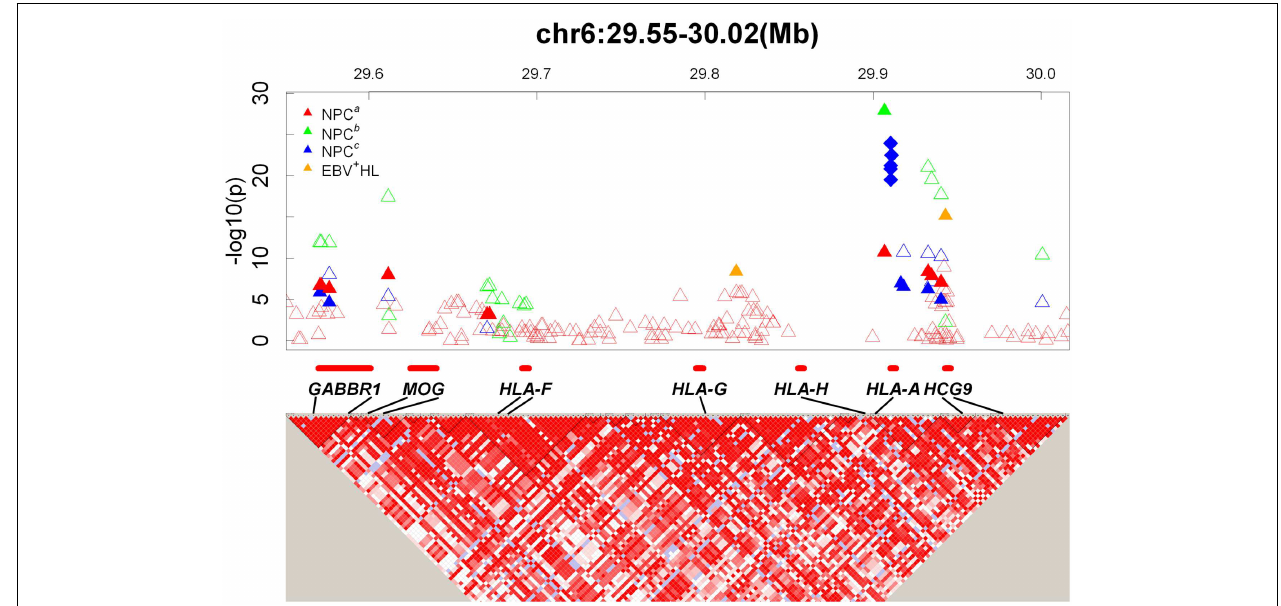
significant SNPs reported in GWASs.The hollow triangles indicate other SNPs listed in the supplementary documents.The solid diamonds indicate significant amino acids located within the HLA genes (12). Bottom: Detailed LD structure depicted in HaploView using control samples from the NPC a GWAS (10).The increasing intensities of red represent lower D (cid:48)